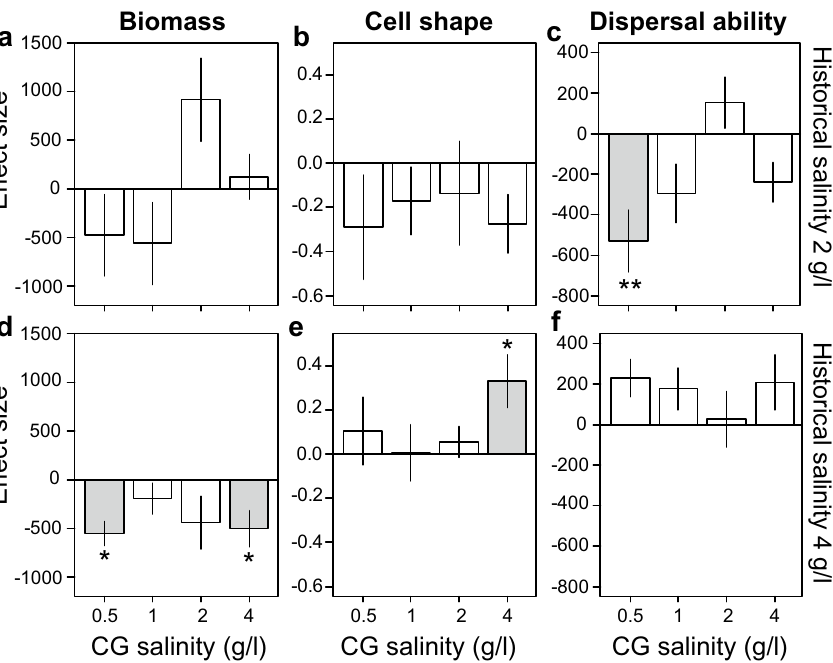
Figure 5. Genetic trait difference between Paramecium aurelia selected populations evolved with and without competitors of the two highest salinity conditions. Bars display the magnitude (i.e. effect size) of the genetic trait difference along the different common garden (CG) salinity environments for the P. aurelia selected populations for ( a , d ) biomass (quantified as bio-area), ( b , e ) cell shape (quantified as cell size ratio of the major and minor cell axis) and ( c , f ) dispersal ability (quantified as gross speed). Top and bottom row display results for P. aurelia populations evolved in the 2 and 4 g/l salinity, respectively (given by historical salinity). Error bars reflect standard errors of the effect size as obtained from the regression model. Grey bars indicate significant effects, with asterisks referring to the level of significance; *< 0.05, **< 0.01, ***< 0.001. Summary of statistical results can be found in Supplementary Table S13. Results of the effect sizes including microcosm ID 120 can be found in Supplementary Figure